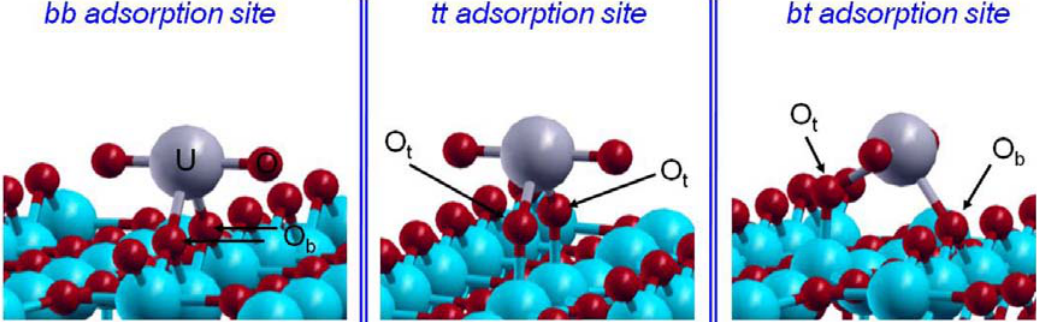
Figure 17. The three crystallographic possible bidentate sorption sites for the uranyl ion on (110) face: bridging-bridging (noted bb ), terminal-terminal (noted tt ) and the rutile TiO 2 finally bridging-terminal (noted bt )